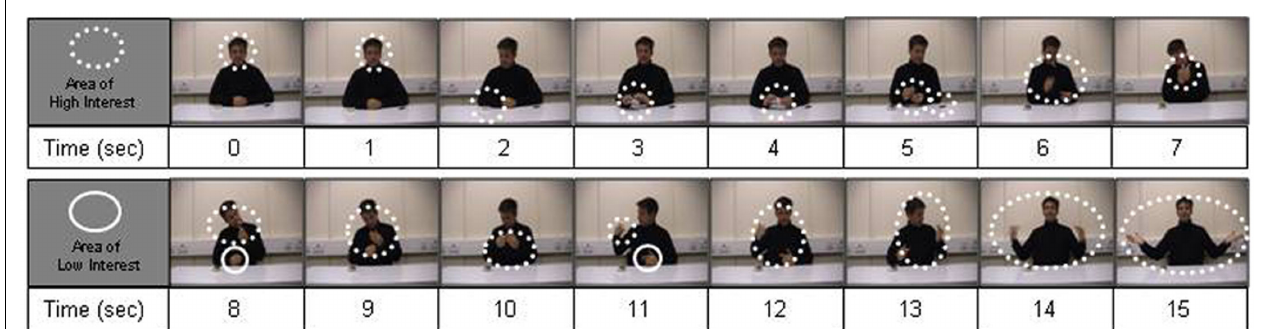
the lighter is lowered to the tabletop and drops the lighter into the magician’s lap.This dropping of the lighter happens in a low area of interest.The disappearing lighter is dramatically revealed by snapping his fingers and waving his hands (11s).The method for making the cigaret disappear relies on it being dropped into the lap.This action is fully visible, with the cigaret dropped from 15cm above the table top (11s). Surprisingly, most participants did not see this: at the time the cigaret is dropped it is an area of low interest (the other hand is an area of